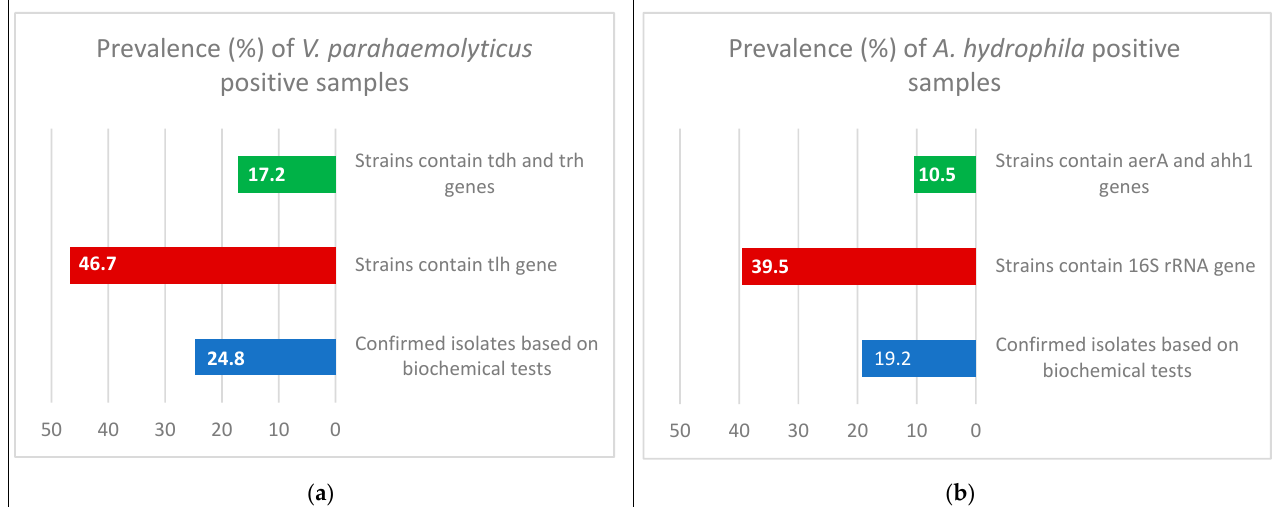
Figure 2. Prevalence and molecular identification of confirmed isolates of V. parahaemolyticus ( a ) and A. hydrophila ( b ) in Nile tilapia.